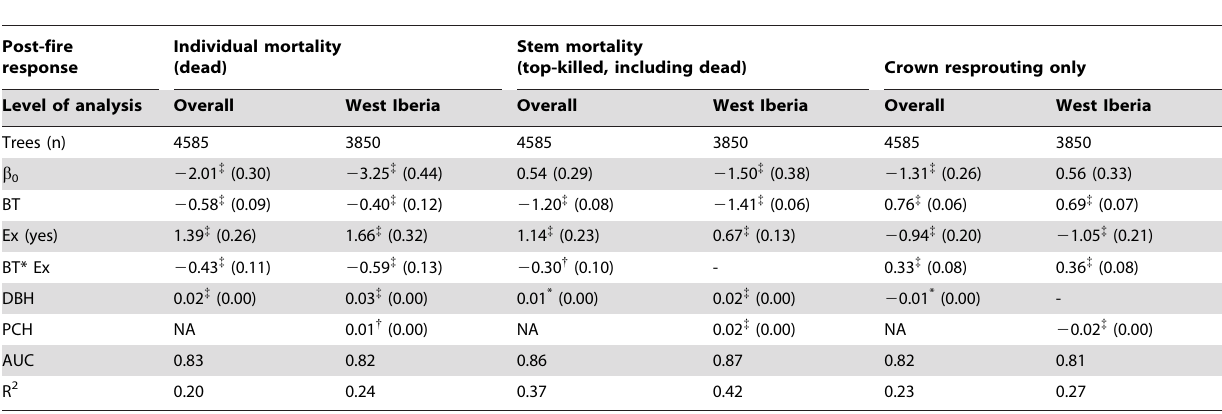
Table 2. Coefficients of the generalized linear mixed-effects models (standard error in brackets) for predicting post-fire Q. suber